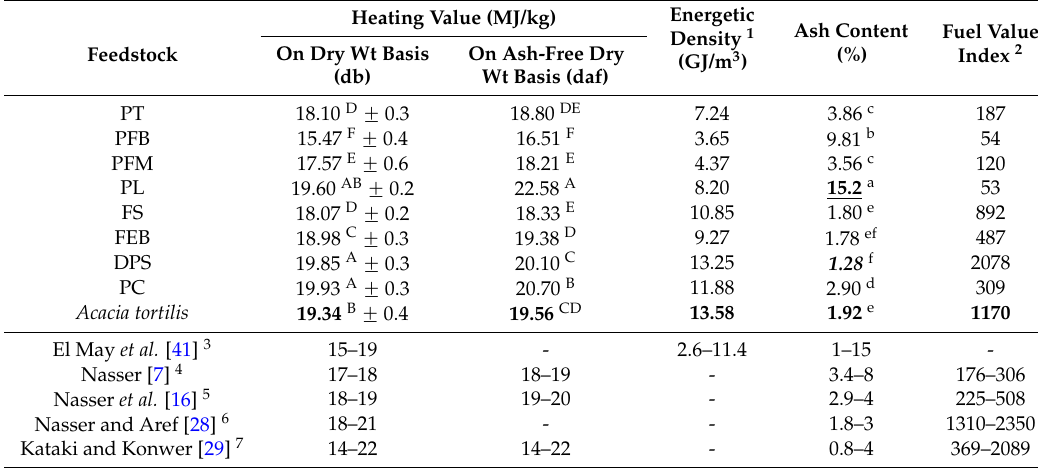
Table 5. Fuel characteristics of the eight date palm